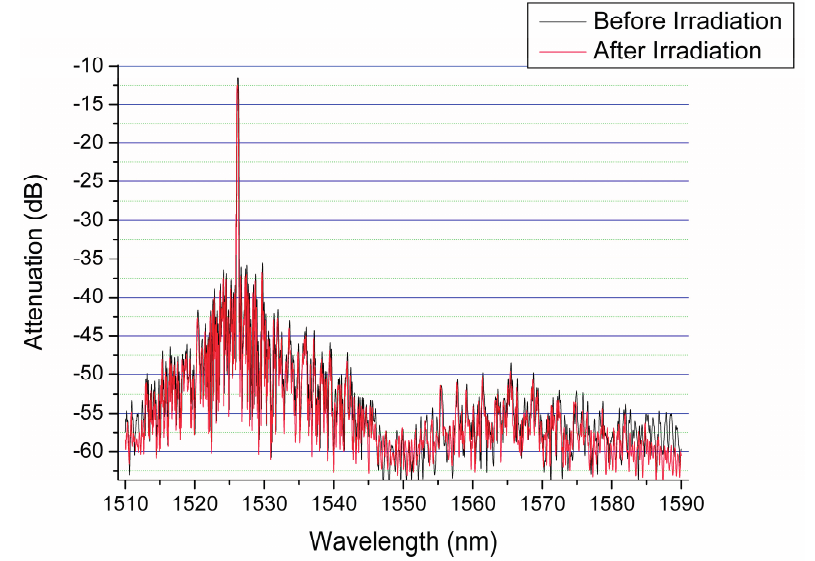
Figure 4. The evaluation of the commercially available FGB parameters: (black) before the irradiation; (red) after exposure to electron beam, measurements done at 23